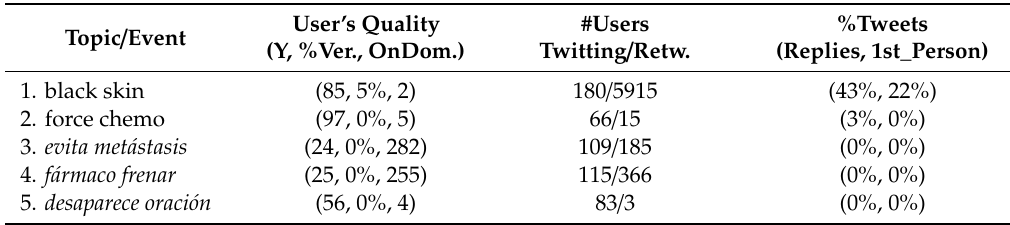
Table 8. Controversial events /